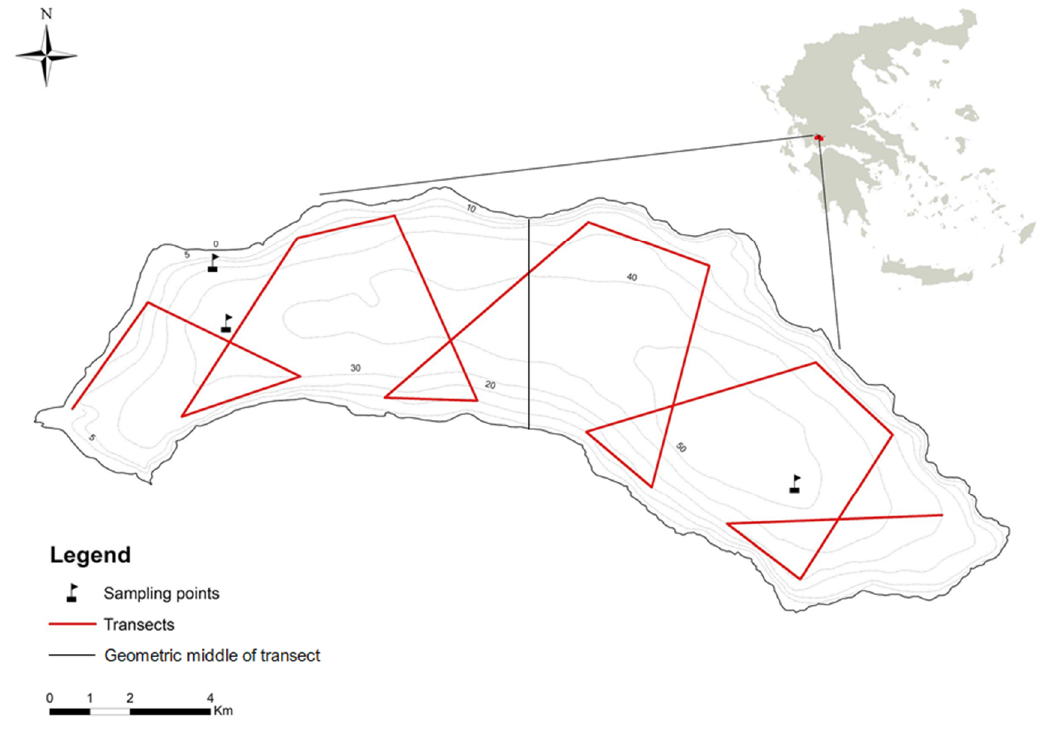
Figure 5. Echosounding traverses and sampling point locations for temperature measurements.